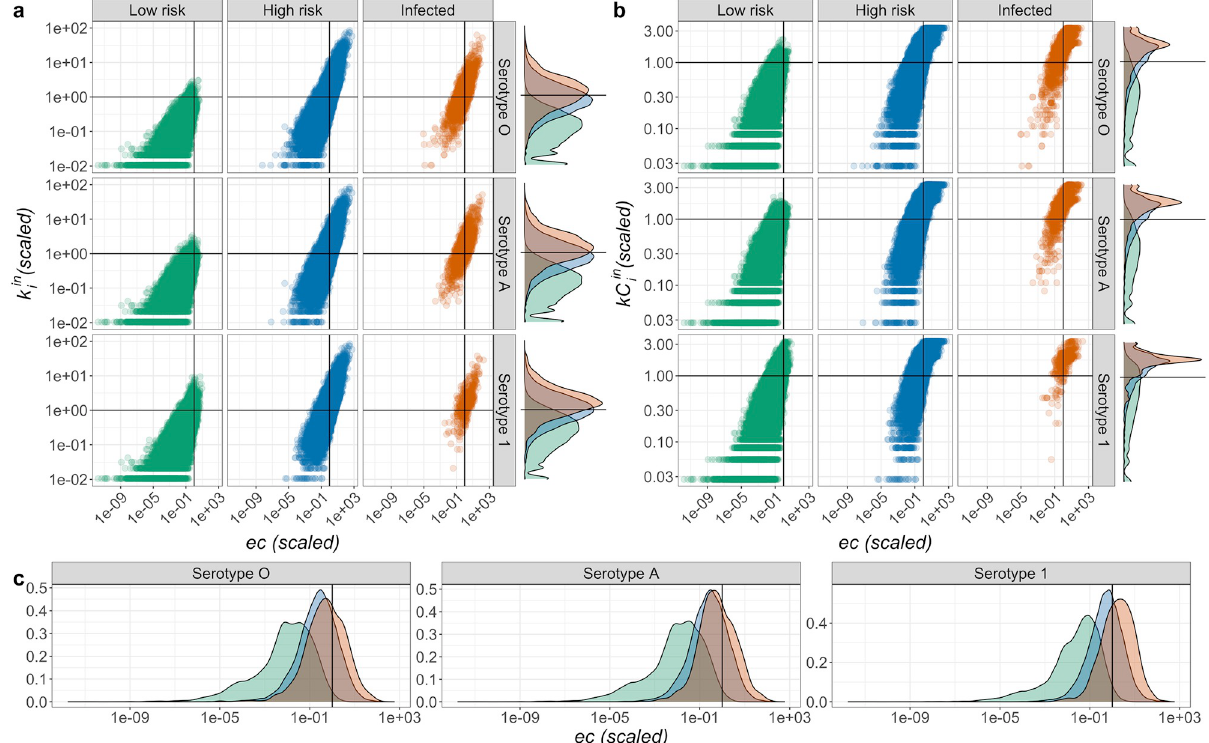
Fig 4. Correlation planes for different network measures of epiunits, by infectious state; i.e. eigenvector centrality ( ec ), in-degree ( k in ), in-coreness i ( kC in ). a . Correlation plane ( ec , k in ). Marginal plots correspond to densities of k in . b . Correlation plane ( ec ; kC in ). Marginal plot corresponds to the i i i i . c . Density plots for ec for each of the three serotypes. k in , kC in and ec have been re-scaled using their corresponding mean value in the densities of kC in i i i complete network. Horizontal lines show, for k in and kC in , the mean value for reference. In all panels colors correspond to low-risk (green), high-risk i (blue), and infected (red) epiunits for each of the three serotypes (rows) ( a and b ). Vertical lines show the location of the mean value for the ec in all plots. Different strains of FMD are as